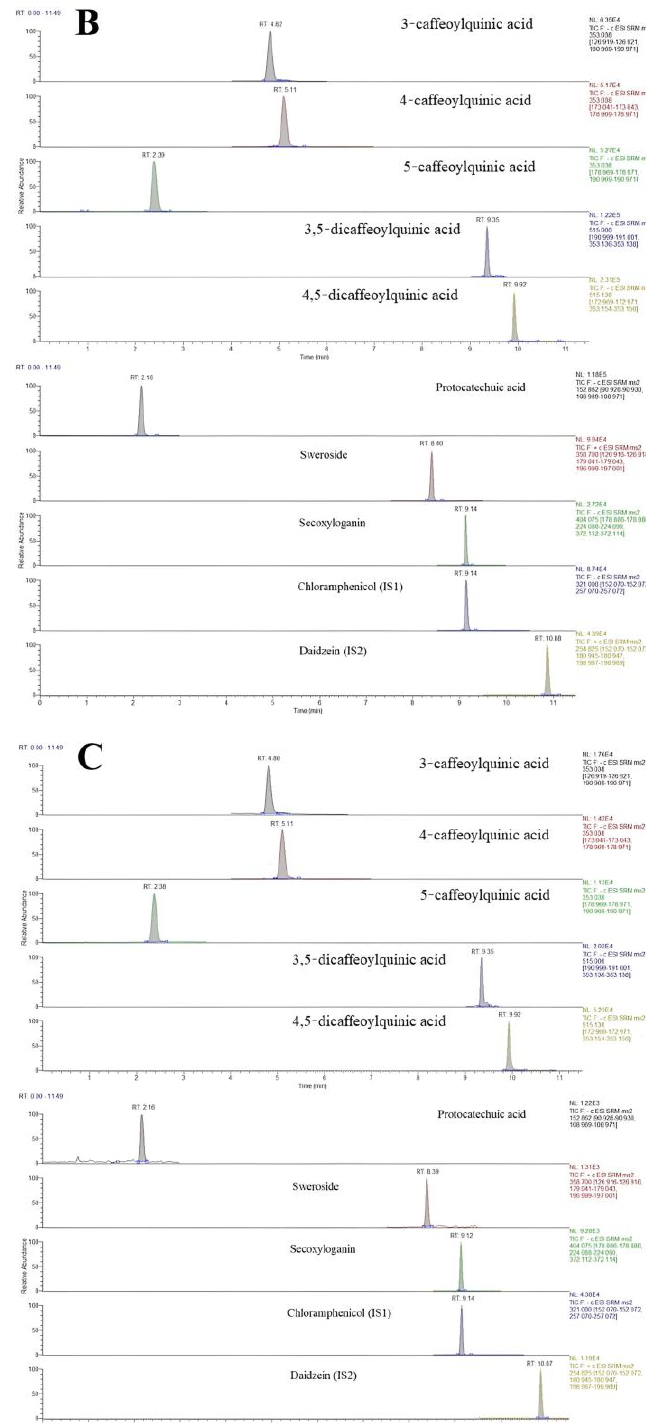
Table 2. The regression equations, linear range, and LLOQs for the eight compounds.